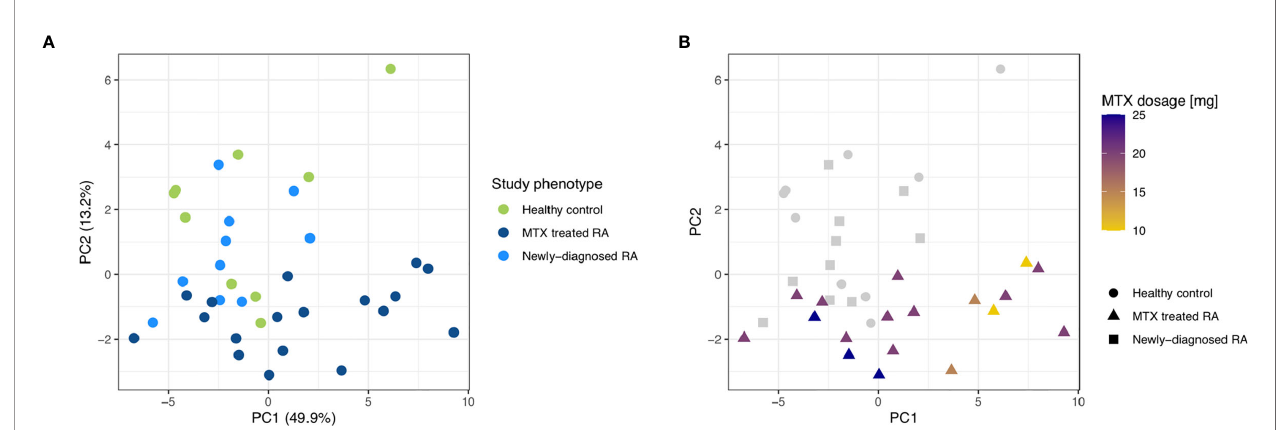
FIGURE 3 | PCA plots for the fi rst two principal components on low read count fi ltered and rlog transformed miRNA read counts of the three study phenotypes. (A) The study phenotypes are indicated by different colors. The percentage of variance explained by the principal component is indicated. (B) MTX dosage is indicated by different colors while different shapes were used to differentiate the study